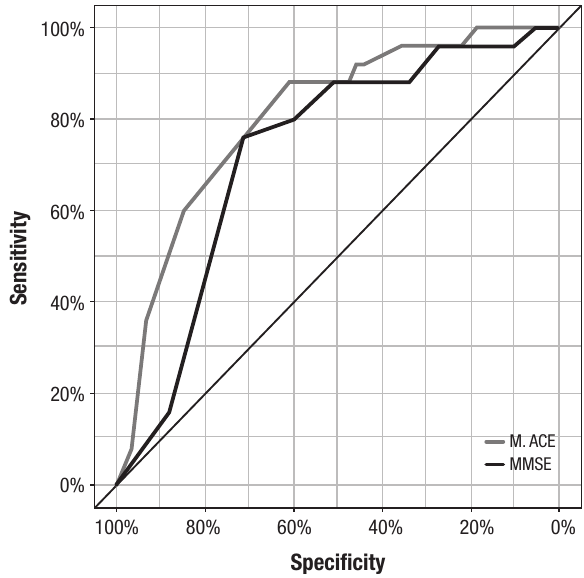
Figure 1. M-ACE and MMSE ROC Curves for differentiating the AD group from the other groups (MCI +